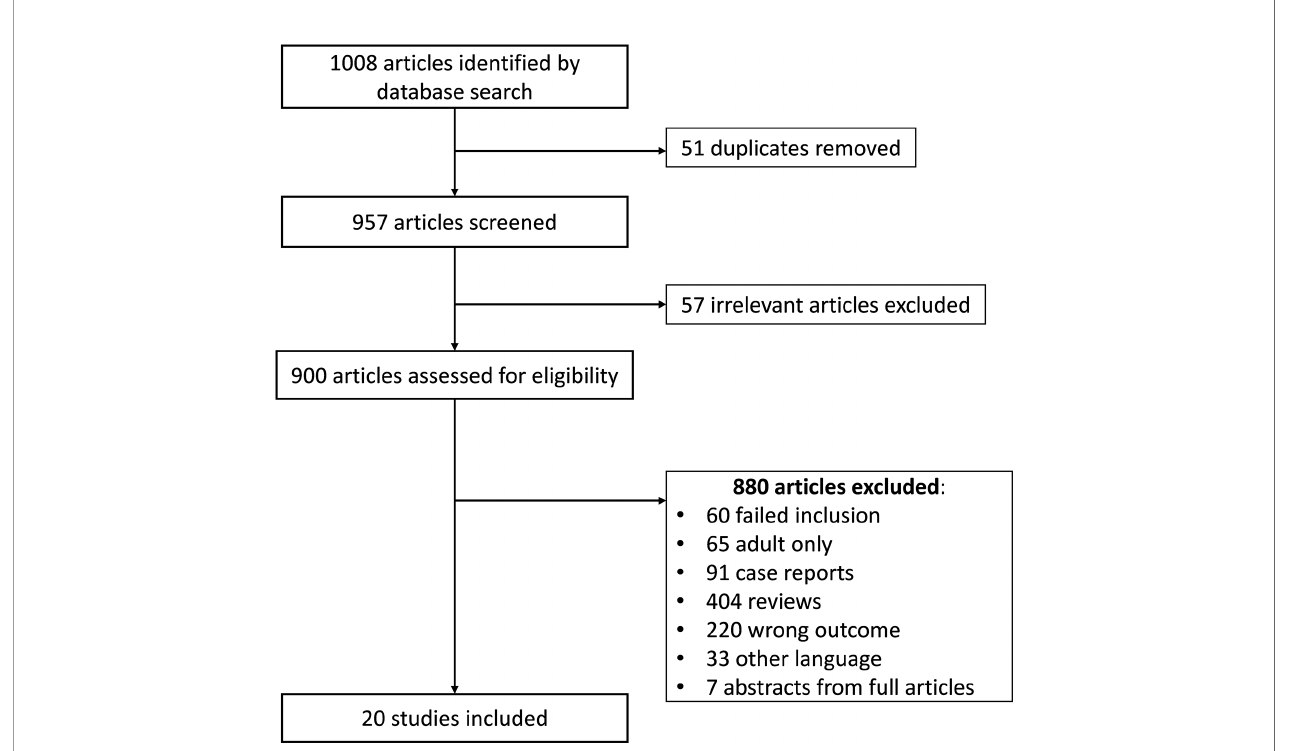
FIGURE 1 | Flow chart of study